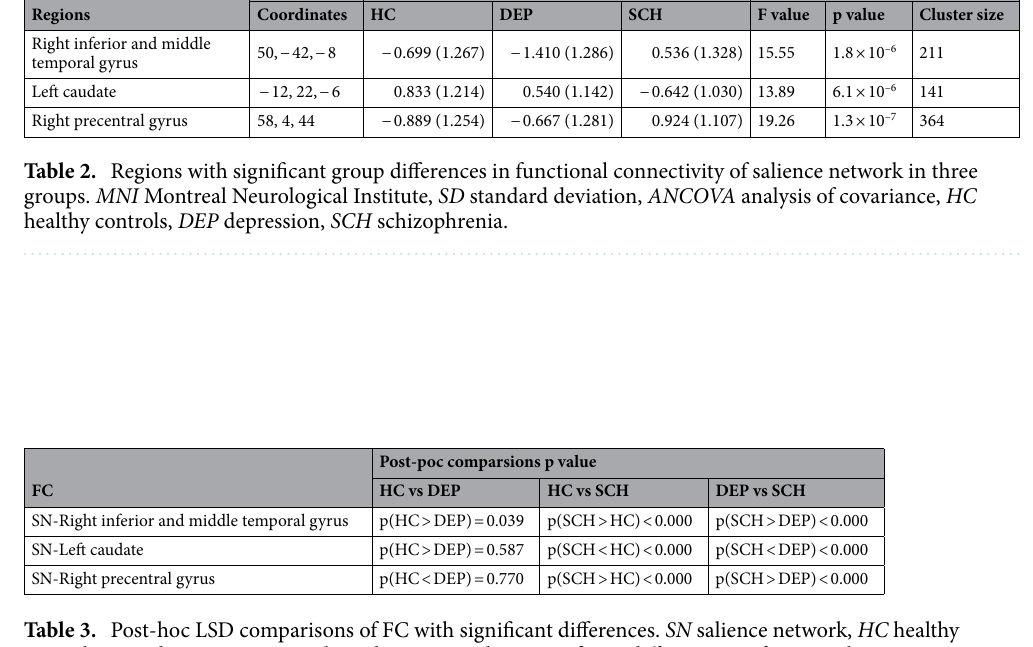
Table 3. Post-hoc LSD comparisons of FC with significant differences. SN salience network, HC healthy controls, DEP depression, SCH schizophrenia, LSD least significant difference, FC functional connectivity.